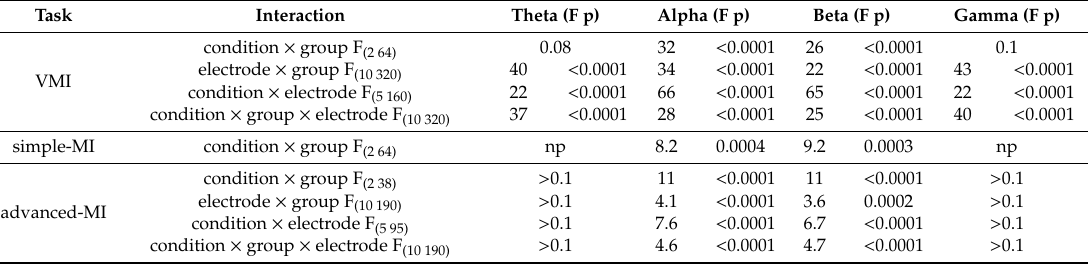
Table 2. ANOVA interactions for ERS / D modulations in each band, group, and electrode group during motor tasks. Delta frequency range was not significant (not shown). np not